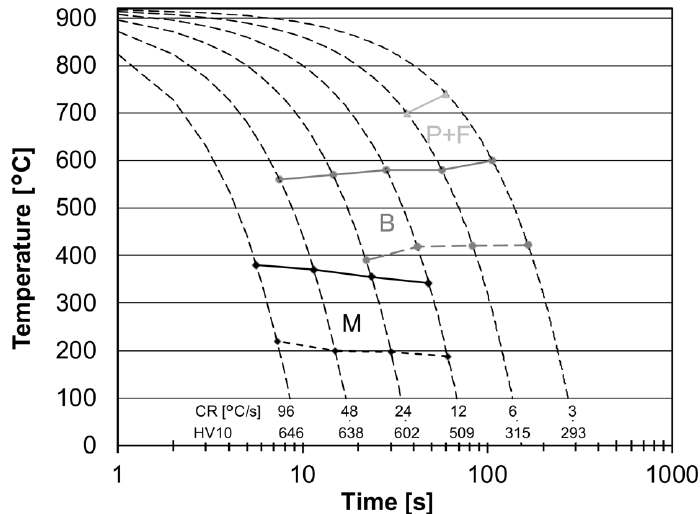
Figure 1. Continuous cooling transformation (CCT) diagram for the steel. Abbreviations: P + F is pearlite and ferrite, B is bainite and M is martensite.